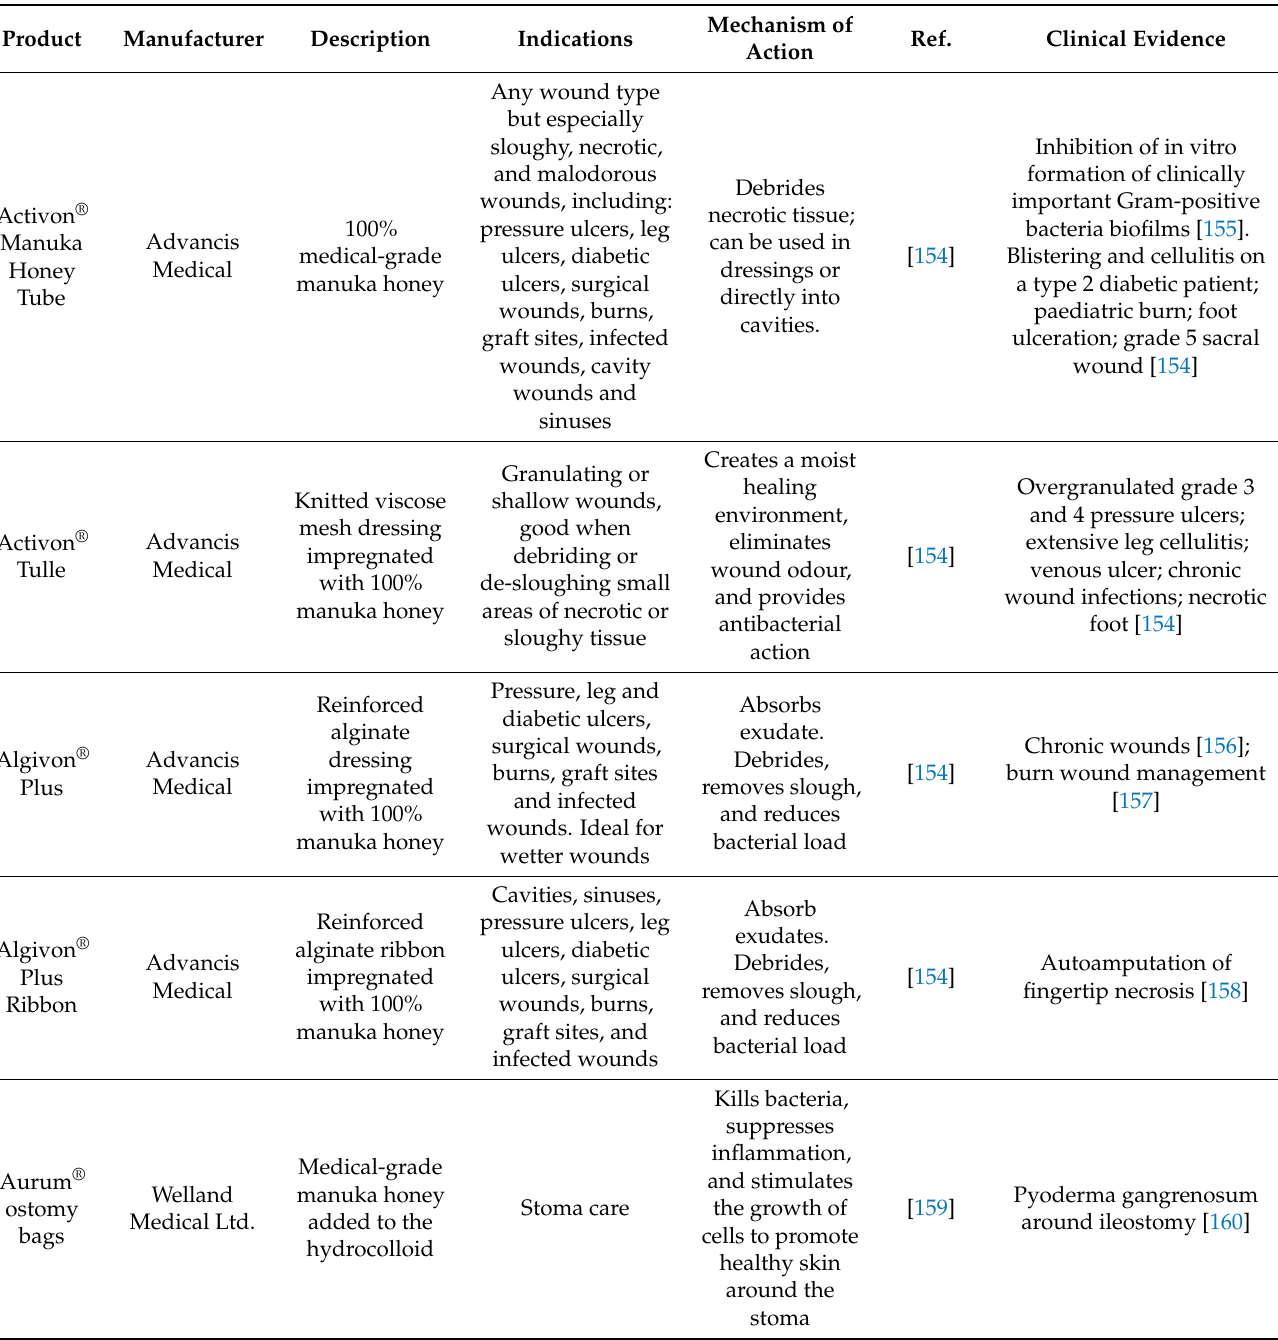
Table 1. Commercially available honey-based wound healing